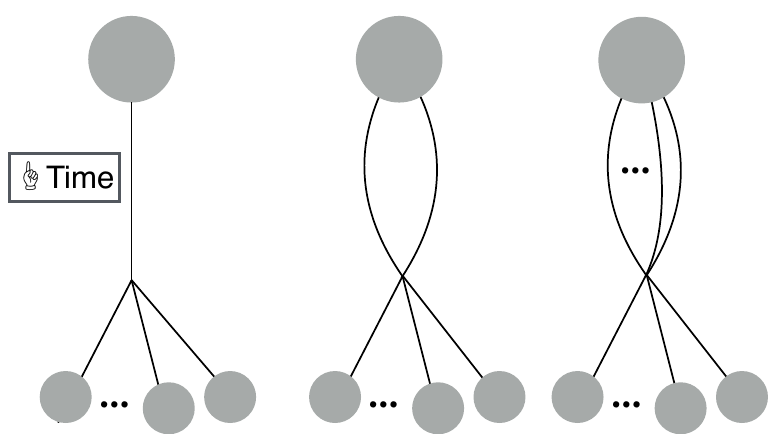
( i ) , Figure 6 . These diagrams show di(cid:11)erent numbers of G R entering a general vertex, at time (cid:17) from the future, where all G + lines are omitted. This illustrates for how many loop momenta that vertex is the earliest time they touch. In the left case, with only one retarded propagator from the future, its momentum necessarily (cid:13)ows further into the past, and (cid:17) ( i ) is the earliest time for zero momenta. In the middle case, having two retarded propagators enter the vertex means a loop momentum can be routed down one and up the other, making (cid:17) ( i ) the earliest vertex through which that momentum (cid:13)ows. In the general case, shown on the right, the argument generalizes such that if (cid:17) ( i ) is the earliest time for N i retarded propagators, it is also the earliest time vertex that N i 1 (cid:0) loop momenta (cid:13)ow through. This relation between the powers of (cid:17) ( i ) appearing in G R factors in the integrand and the (cid:17) ( i ) scaling of the loop momenta UV cuto(cid:11)s determines the k IR scaling of the graph given in eq. (B.3) for the generic arrangement of G R and G + propagators. physical cuto(cid:11) (cid:3) = ( H (cid:17) ). 15 For uniform treatment of pairs of times that are strongly